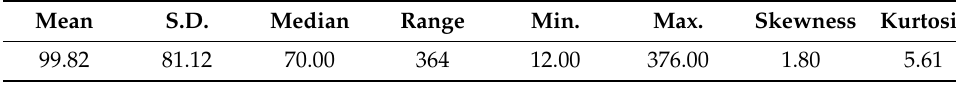
Table 8. Descriptive analysis for the survival times of guinea pigs.